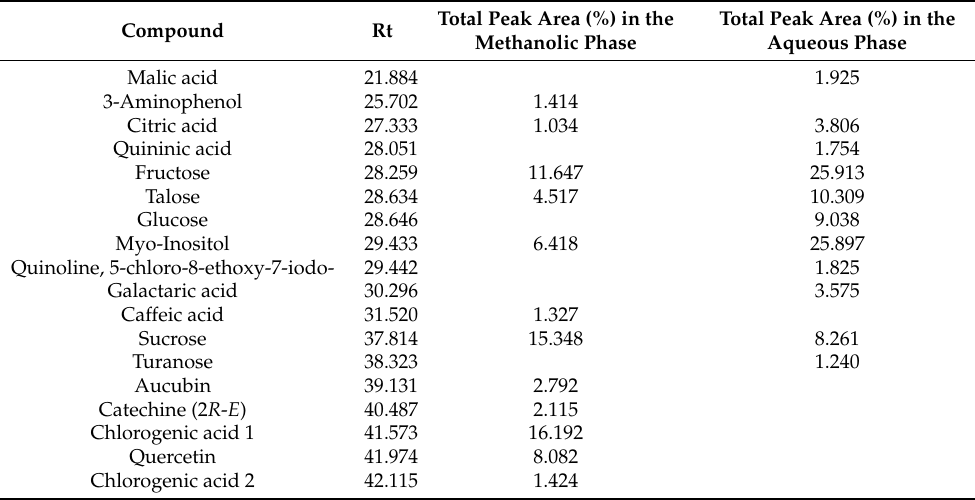
Table 1. Main compounds identified in the methanolic and aqueous phases of Pulicaria incisa infusion. Compound